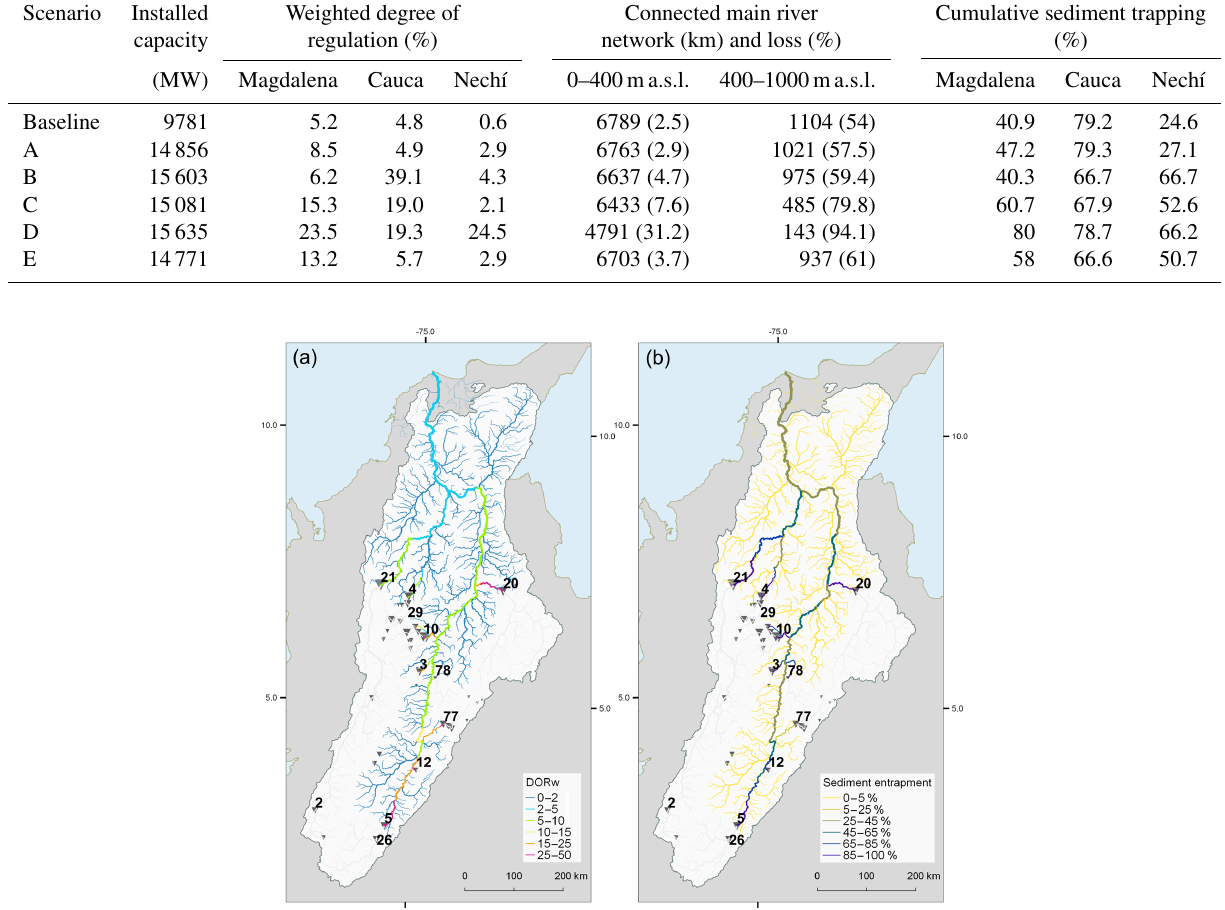
Figure 7. Baseline cumulative impacts of existing and under-construction dams in the basin (symbolized by triangles): (a) DOR w weighted degree of regulation and (b) percentage of sediment entrapment due to upstream reservoirs. Fragmented sections of river network are greyed out. Selected projects labeled with IDs used in Table